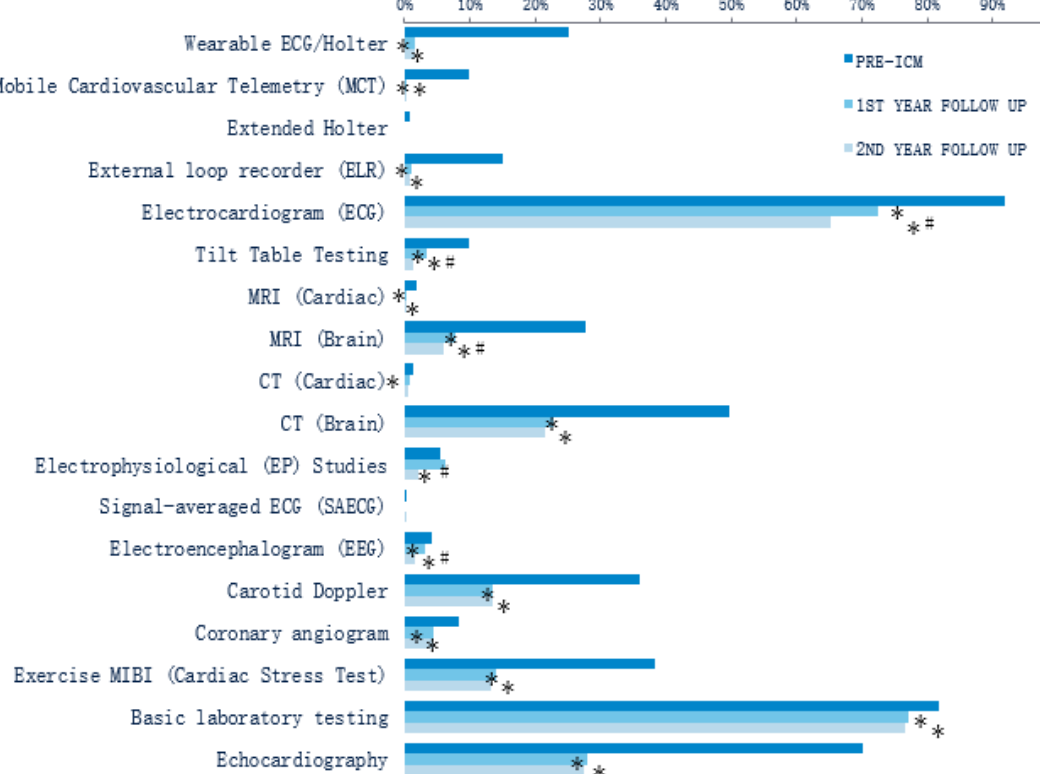
Figure 2. Diagnostic tests used in an attempt at clinical diagnosis (whole cohort; n = 2140). * p < 0.05 when either the 1st-year or 2nd-year follow-up were compared to pre-ICM; # p < 0.05 when the 2nd year of follow-up was compared to the 1st year of follow-up. During the 2-year follow-up period post-ICM, repeated use of the same diagnostic test was rare (<5% of patients) for all tests except: ECG (71.2% of patients with ≥ two tests), computed tomography (CT) of the brain (21.4%), carotid Doppler (8.7%), cardiac stress test (13.7%), basic laboratory testing (39.6%), and echocardiography (21.8%); Table S4. Diagnostic testing was also assessed for the subset of patients with an acute syncope event (i.e., syncope coded in the emergency room or inpatient setting) during the pre-ICM period ( n = 885). Consistent with our broader patient population of patients with a general history of syncope (syncope coded in any care setting), a decrease in diagnostic testing between pre-ICM and the subsequent 2 years of follow-up was also found in those with prior acute events (Figure S1). Diagnostic test utilization for the three study periods was compared between pa- tients with ( n = 885) vs. those without ( n = 1255) an acute syncope event during the pre- ICM period. Patients who had an acute syncope event had significantly more tests per- formed than those without in the 12 months pre-ICM (ECG, tilt table, MRI of the brain, CT of the brain, EPS, EEG, carotid Doppler, coronary angiogram, cardiac stress test, basic laboratory testing, and echocardiography; Table S5). Only a wearable ECG/Holter was more frequently used in patients without acute syncope (Table S5). In contrast, during the first and second years of follow-up, there were few differences in diagnostic test utiliza- tion between patients with vs. without acute syncope events during the pre-ICM period (Tables S6 and S7).